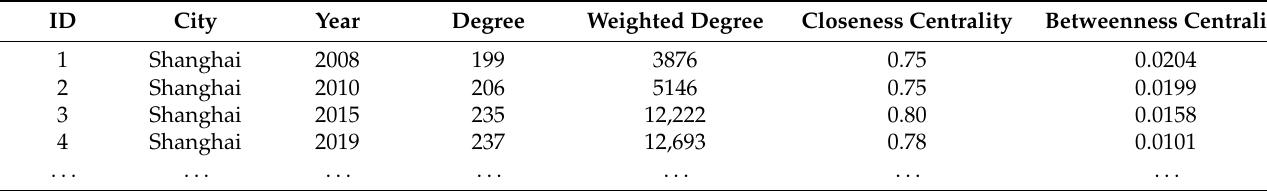
Table 2. Input data.